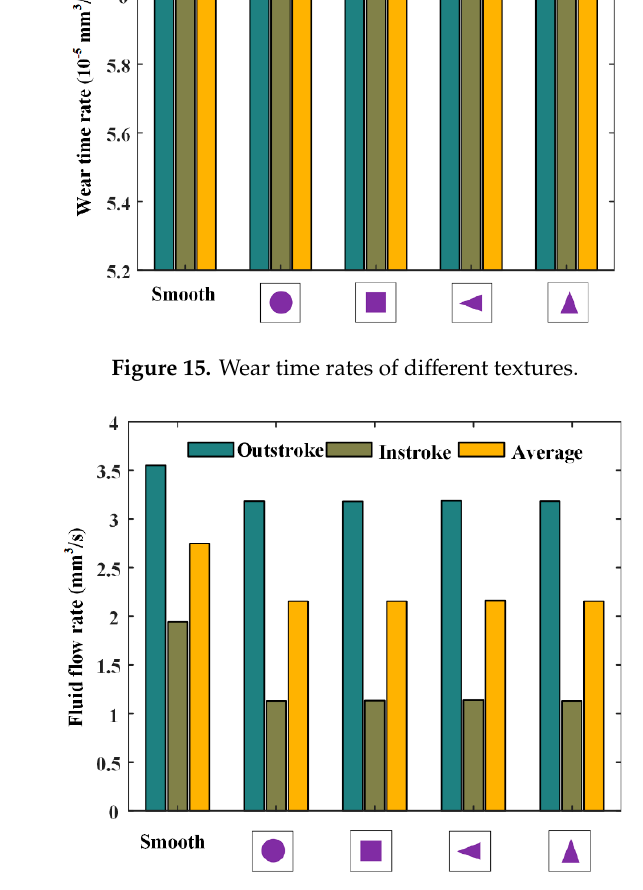
Figure 16. Fluid flow rates of different textures.